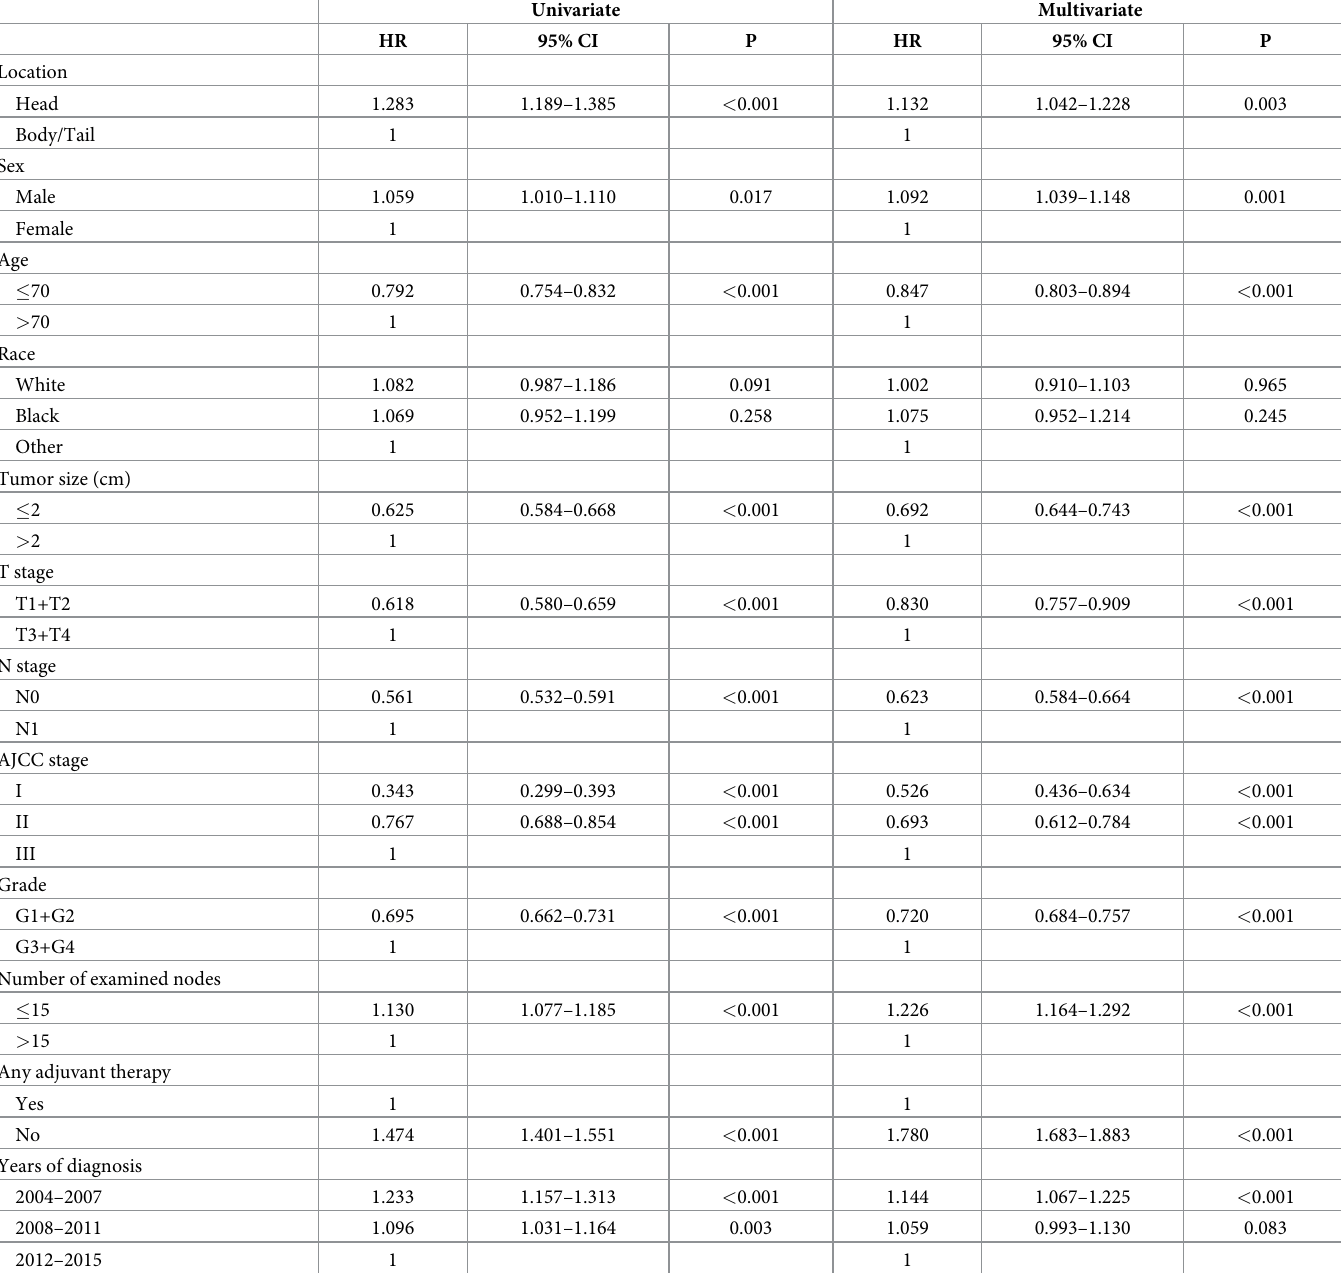
Table 4. Univariate and multivariate analysis of CSS in patients who underwent curative intent surgery for pancreatic cancer.